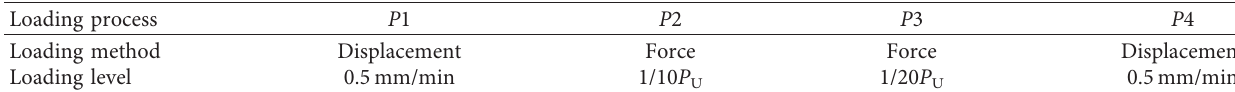
Figure 7: Experimental axial compression device. Table 5: Loading